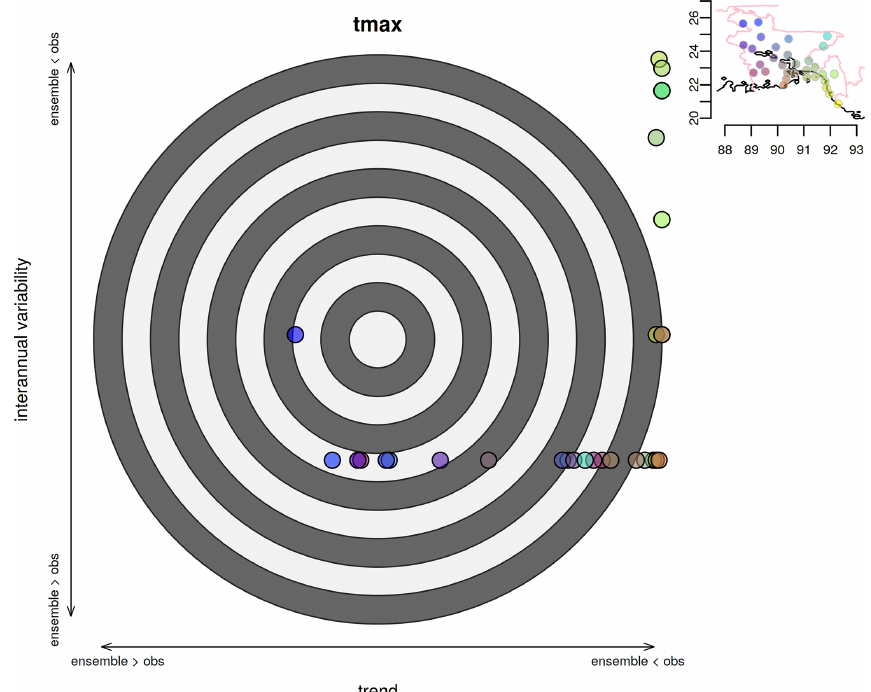
Figure 6. Evaluation of the ensemble of statistically downscaled maximum temperature in the pre-monsoon season (March–May) based on emission scenario RCP4.5 and observations in the period 1981–2019. Each point represents a station and the colors show the geographical location as seen in the map in the upper right corner. The x axis shows the probability of the observed trend given a distribution with the statistical characteristics (mean and standard deviation) of the trends of the downscaled ensemble. Values far to the right (left) indicate that the downscaled ensemble is underestimating (overestimating) the trend. The y axis shows the probability of finding the observed number of values outside of the downscaled ensemble 90% confidence interval, which is taken as a measure of how well the ensemble represents the interannual variability. Values towards the top (bottom) suggest that the downscaled ensemble underestimates (overestimates) the interannual